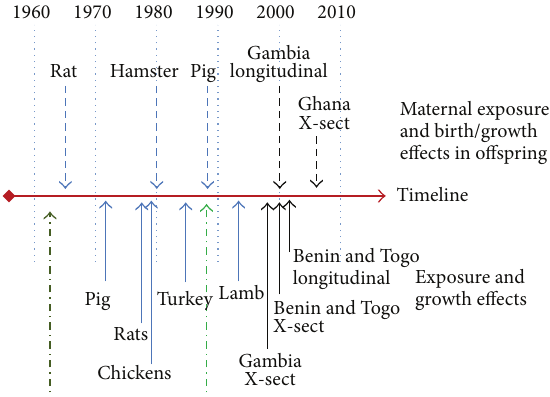
Figure 5: A timeline for the discovery and identification of aflatoxin and key studies in animals and humans on growth in relation to dosing or natural exposure, respectively. Human data only includes validated exposure biomarker driven studies; additional human studies published between 1989 and 2010 further support these observations (see text). Modified from [21, 22,